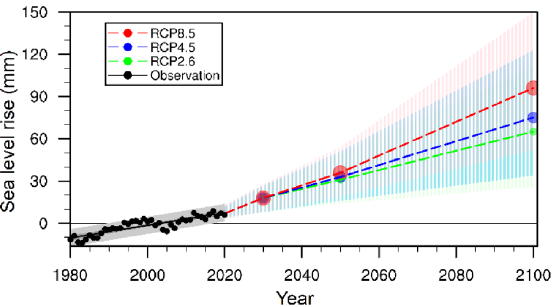
Figure 5. Historical and future relative sea level changes along coastal Dongzhaigang, Haikou City from 1980 to 2100; the 5–95% uncertainty ranges are shaded for RCPs 2.6, 4.5, and 8.5, respectively.